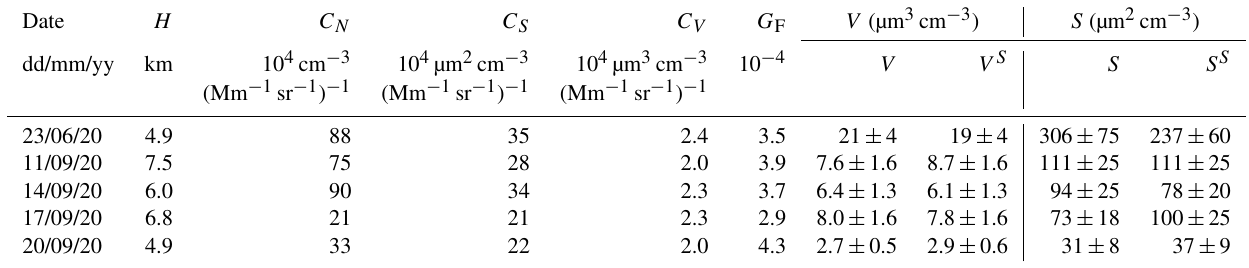
Table 1. Conversion factors C N , C S and C V and fluorescence capacity G F at height H for five smoke episodes. Volume and surface area concentrations of smoke particles, obtained by the inversion of β + 2 α lidar observations ( V , S ), are given, together with values calculated from fluorescence measurements ( V S , S S ) and using conversion factors (Eq.